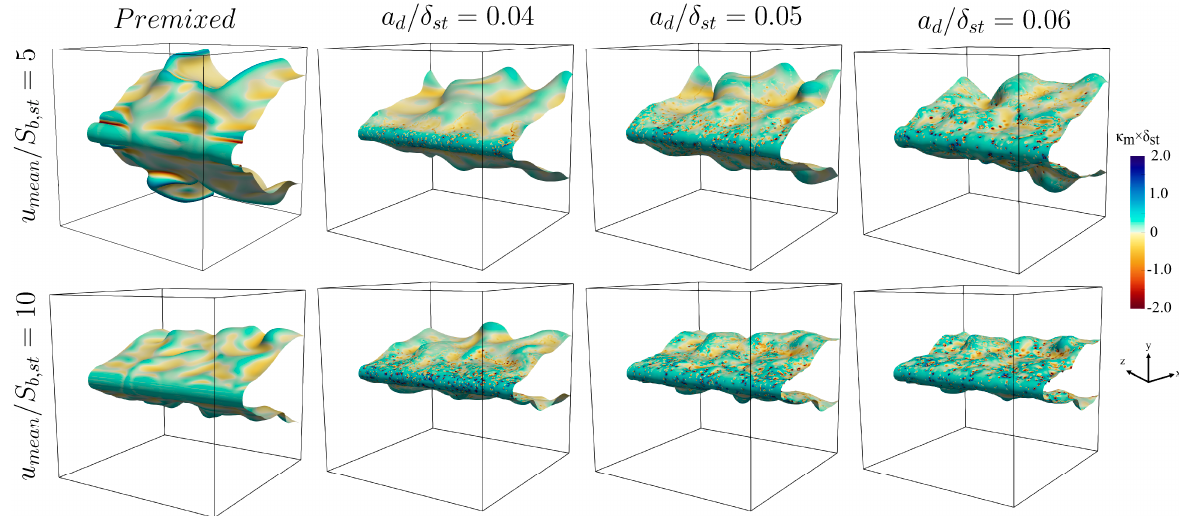
Figure 6. Instantaneous views of c = 0.5 isosurface coloured with κ m × δ st values for gaseous premixed and spray flames with initial a d / δ st = 0.04, 0.05, 0.06 for u mean / S b , st = 5.0 (1st row) and 10.0 (2nd row) at t = 2.0 t flow .